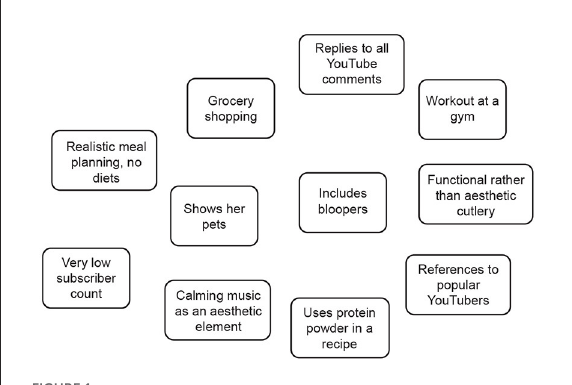
FIGURE1 A sample situational map constructed during level 1 of the AVO analysis of a 7-min YouTube video.